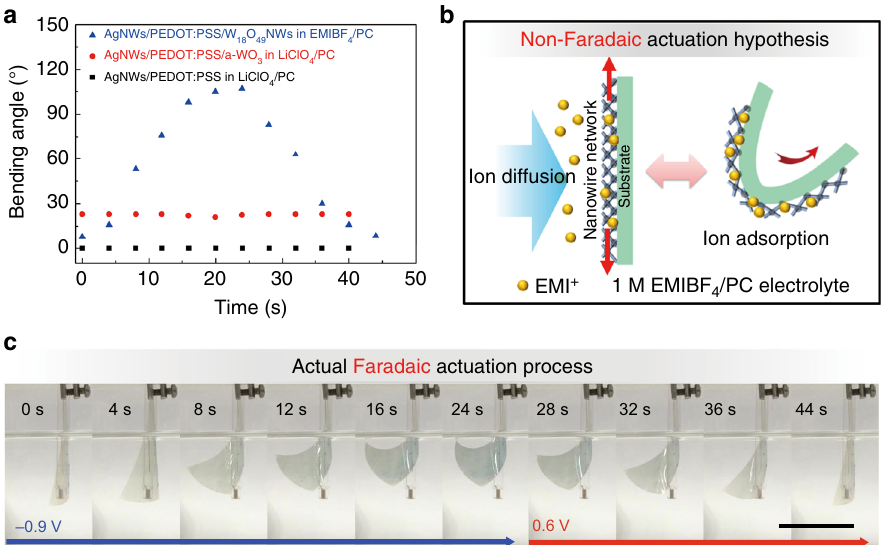
Fig. 2 Three control experiments. a Actuating angles of different fi lms as a function of time. b Theoretical schematic illustration of nonfaradaic reaction- based actuation for the dual-responsive fi lms in 1 M 1-ethyl-3-methylimidazolium tetra fl uoroborate (EMIBF 4 )/ propylene carbonate (PC) electrolyte; c Digital photographs of electrochromic (EC) and deformation processes of the dual-responsive fi lm (Scale bar: 3 cm) measured in 1 M EMIBF 4 /PC electrolyte, respectively. (NWs is nanowires, PEDOT:PSS is